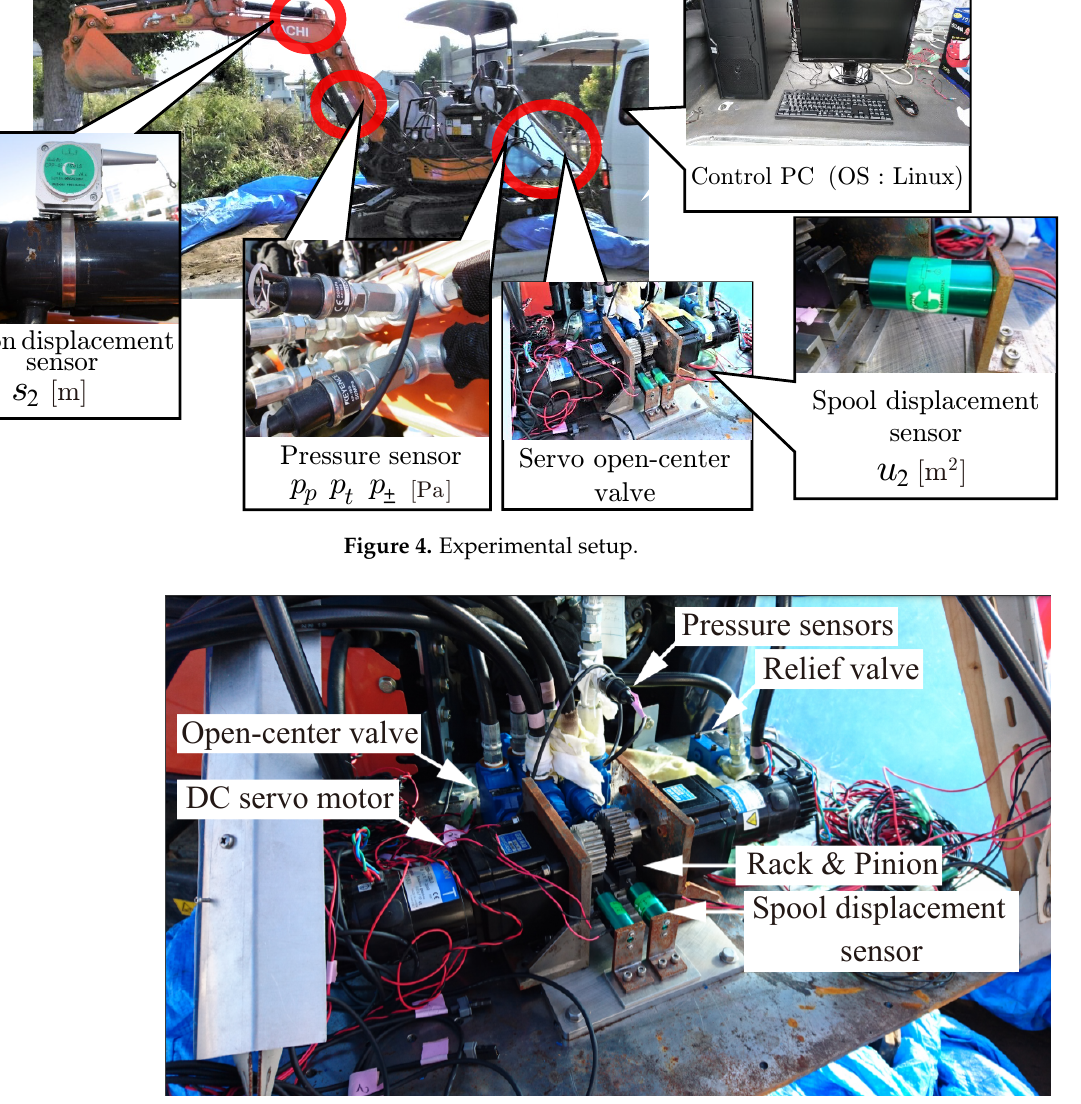
Figure 5. Servo open-center